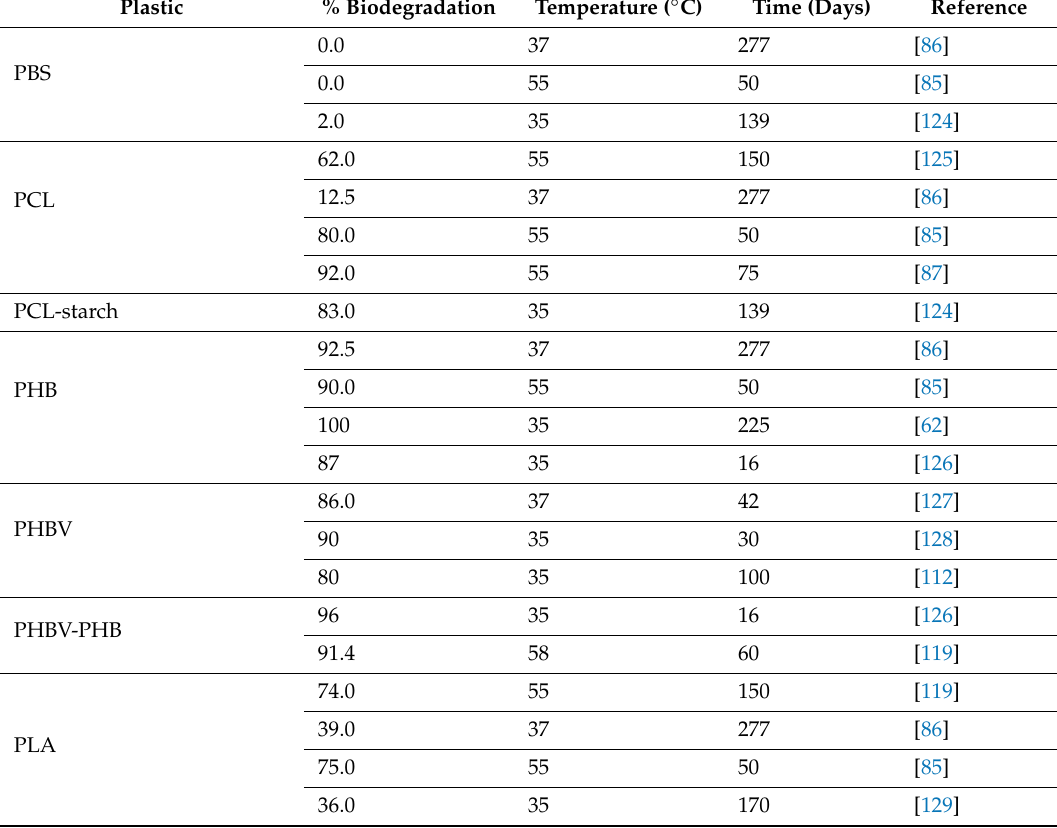
Table 3. Biodegradation of di ff erent biodegradable and conventional plastics in anaerobic